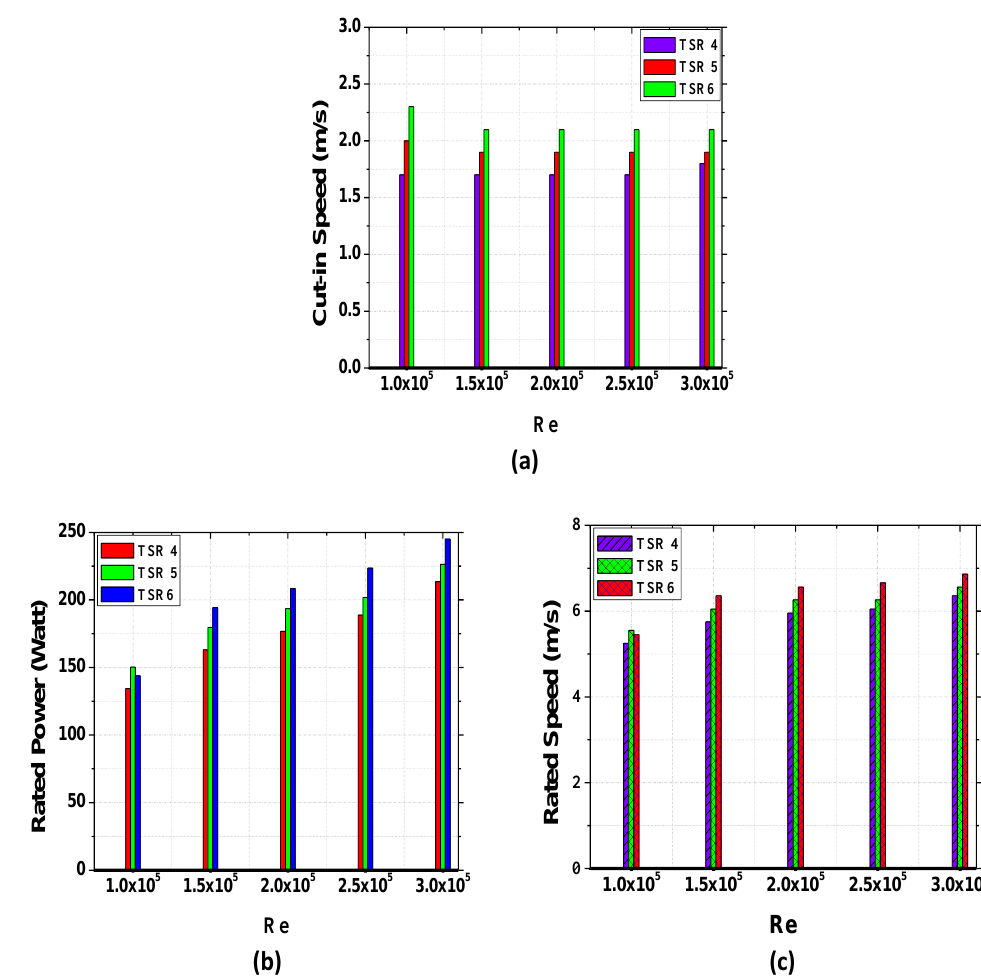
Figure 19. ( a ) Cut-in Speeds; ( b ) Rated powers; ( c ) Rated Speeds for SG6043 rotor blade.